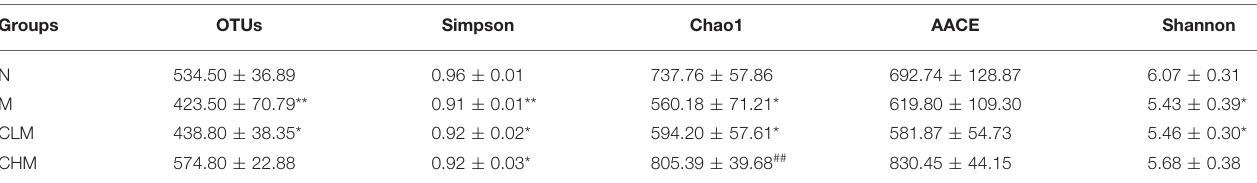
TABLE 2 | α -diversity indices of gut microbiota in each